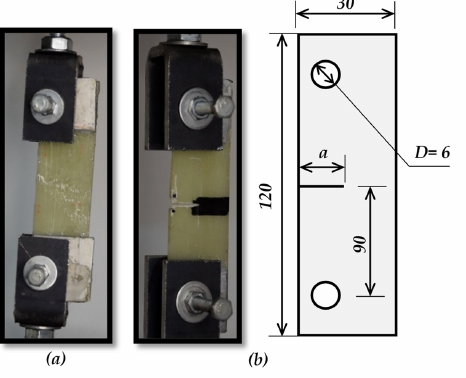
Figure 3. The geometry of ASTM E1922 specimens, ( a ) smooth specimen, and ( b ) TTC Specimen. All dimensions in mm.